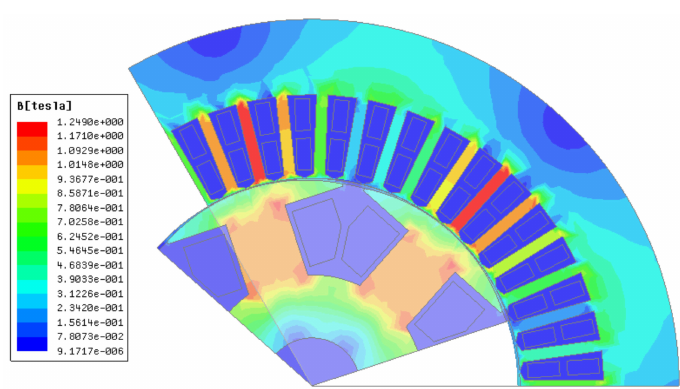
Figure 15. Magnetic-density distribution map of the generator.